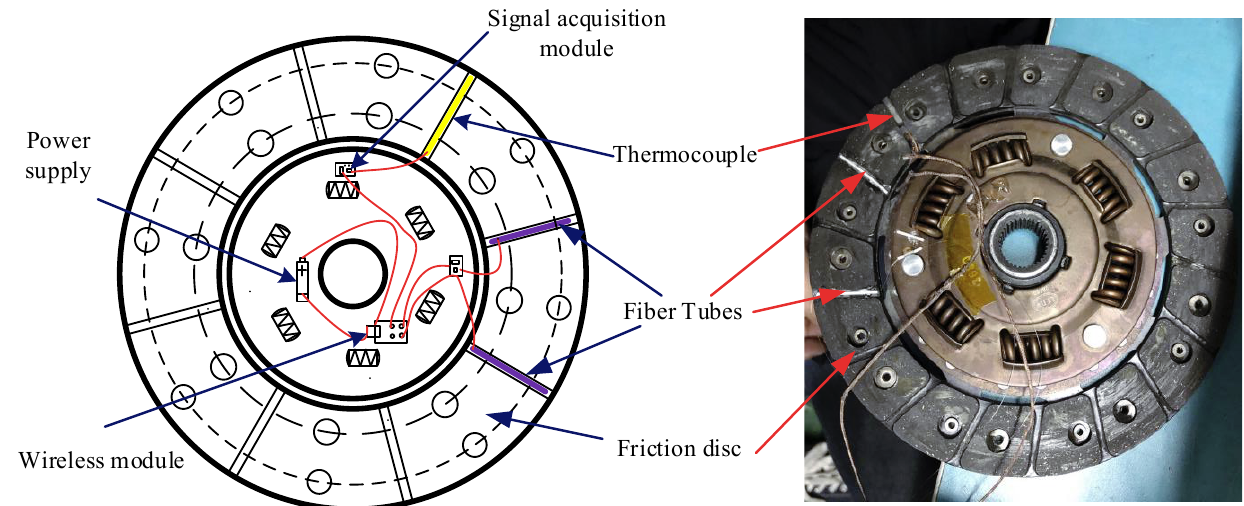
Figure 4. Arrangement of the optical